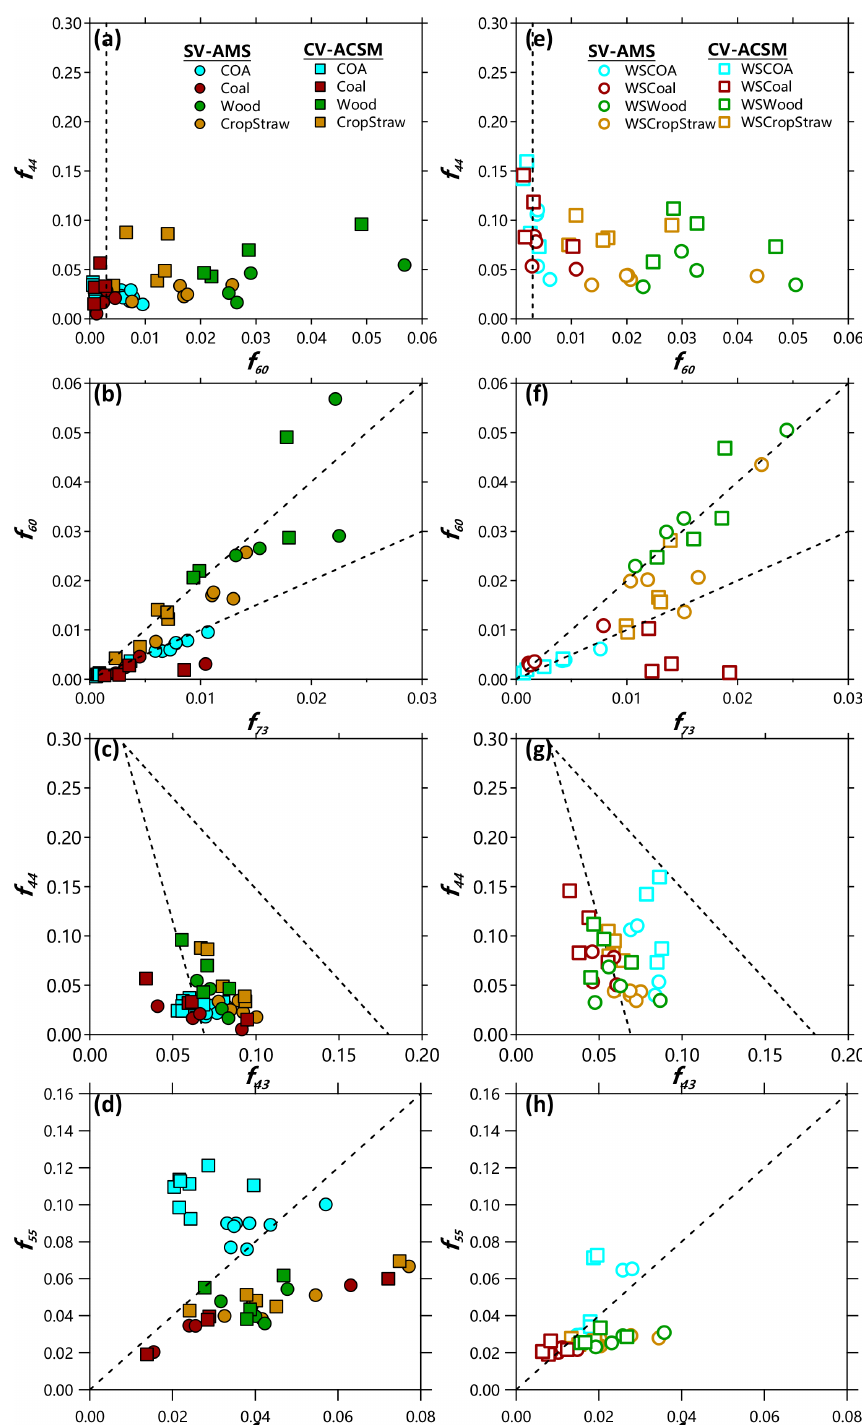
Figure 6. Scatter plots of (a, e) f 44 vs. f 60 , (b, f) f 60 vs. f 73 , (c, g) f 44 vs. f 43 , and (d, h) f 55 vs. f 57 for OA (a–f) and WSOA (c–h) from SV-AMS and CV-ACSM